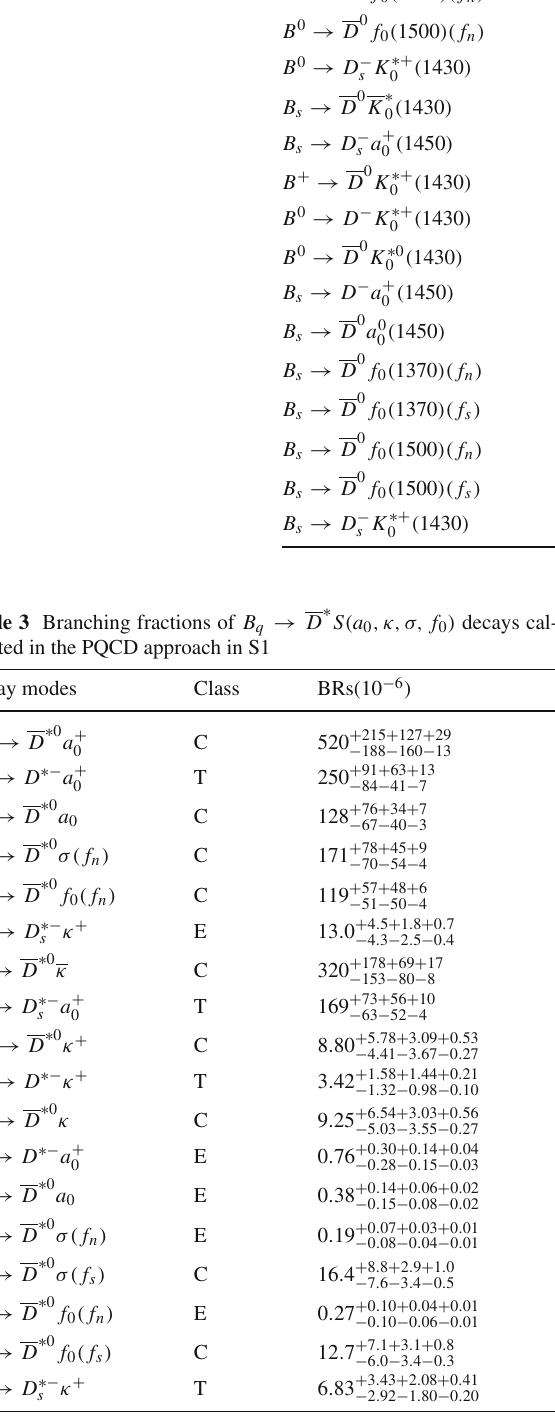
Table 2 Branching fractions of B ( s ) → DS ( a 0 ( 1450 ), K ∗ and f 0 ( 1500 )) calculated in the PQCD approach in S1 and S2, respectively